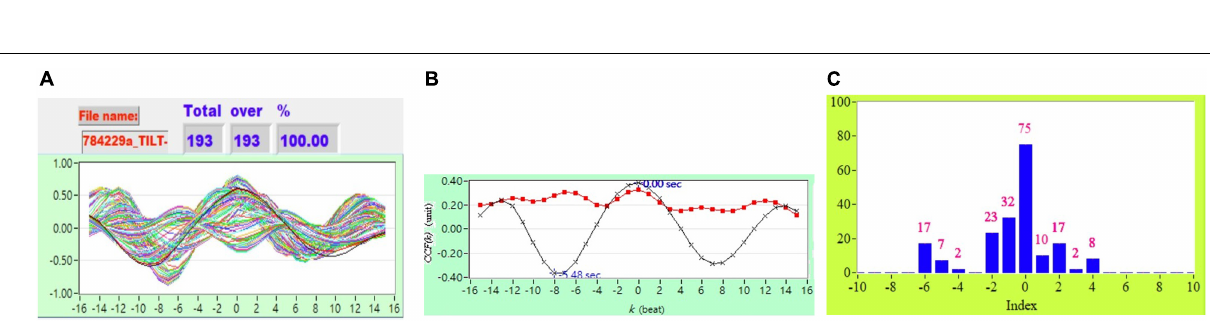
FIGURE 1 | Representation of the ABP signal, the red circle is the blood pressure wave peak.